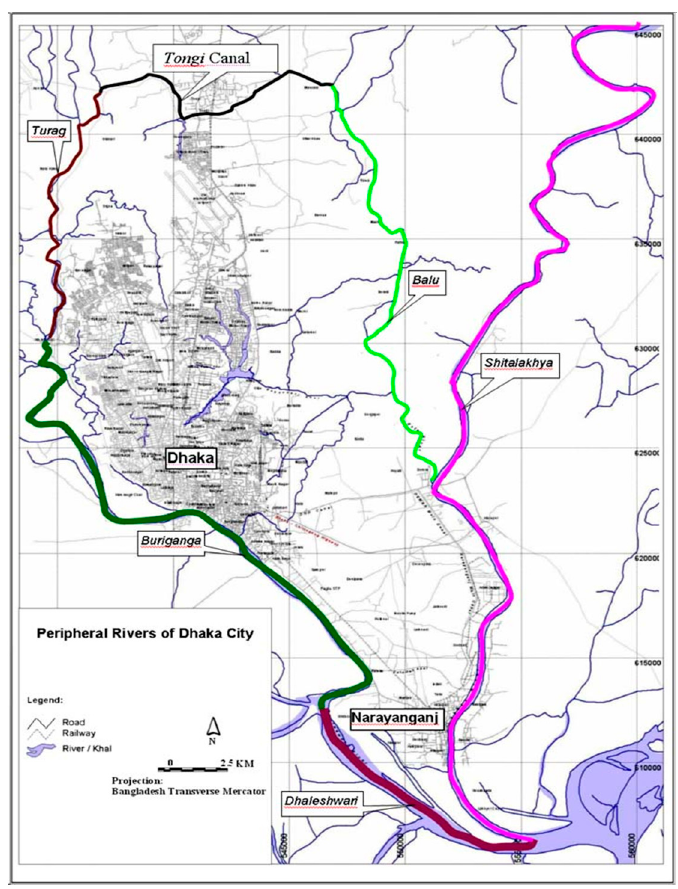
Figure 1. The Buriganga crossing Dhaka and its connection with other rivers.